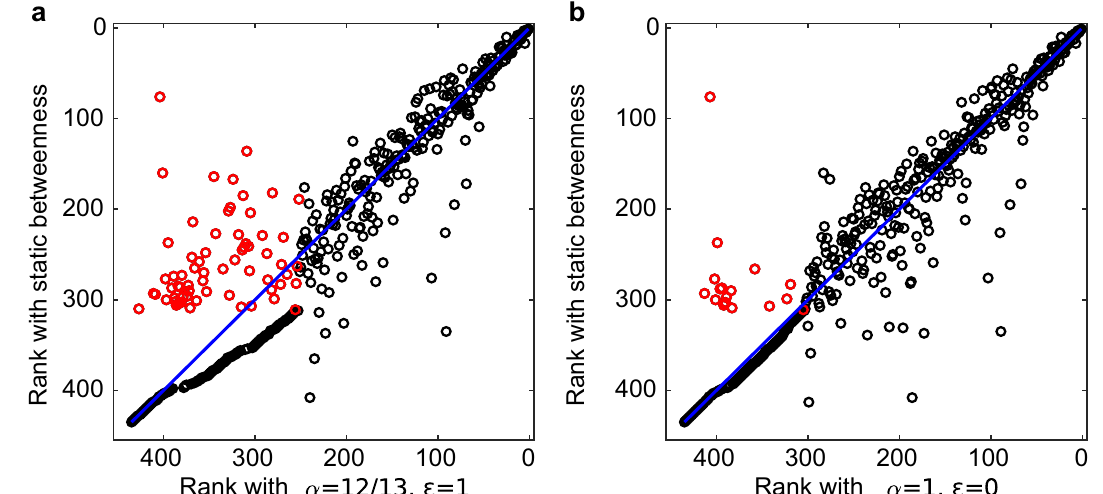
Figure 3. Comparison between the ranking according to the static betweenness on the aggregated network (method (i)) and the betweenness proposed here, computed with ε = 1 and α = 12 / 13 (panel a ) and α = 1 (panel b ). Each dot represents an airport, red dots are airports having b stat > 0 but b = 0 . The blue line is